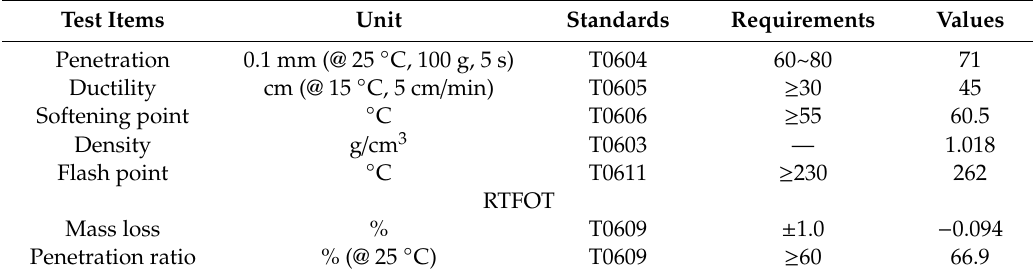
Table 1. Technical properties of styrene-butadiene-styrene (SBS)-modified asphalt.